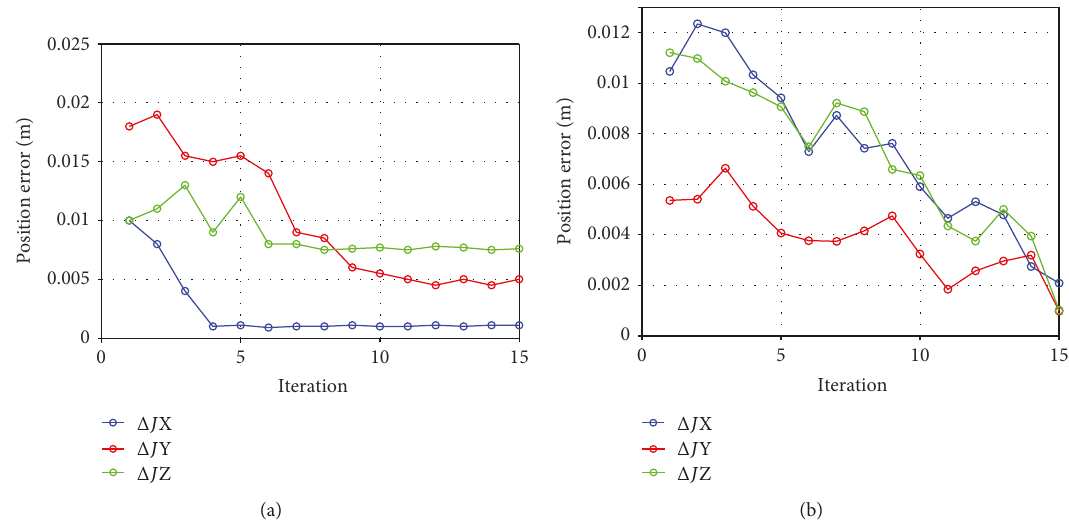
Figure 7: The di ff erence between the estimated position of (a) R